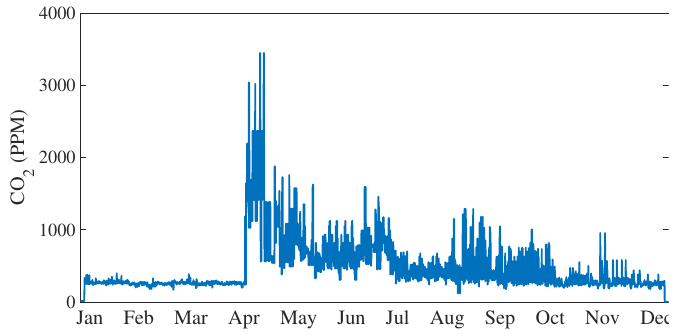
Figure 8. CO 2 measurement during one